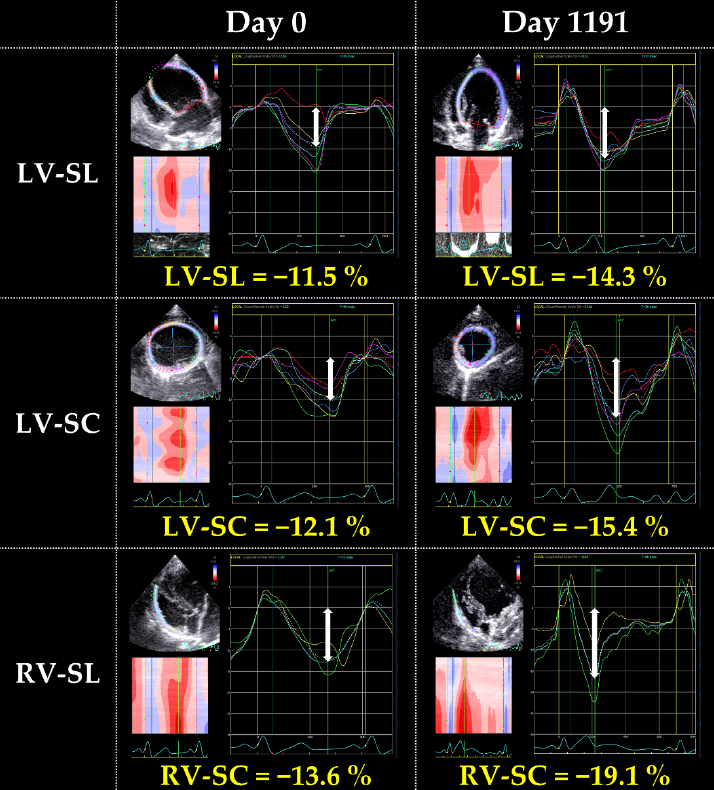
Figure 3. Changes in left ventricular longitudinal strain on day 0 and day 1191.